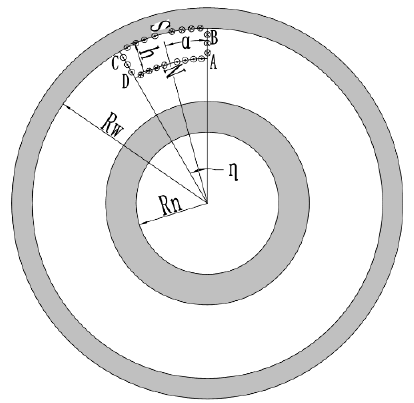
Figure 2. Equivalent current of a PM during parallel charging.